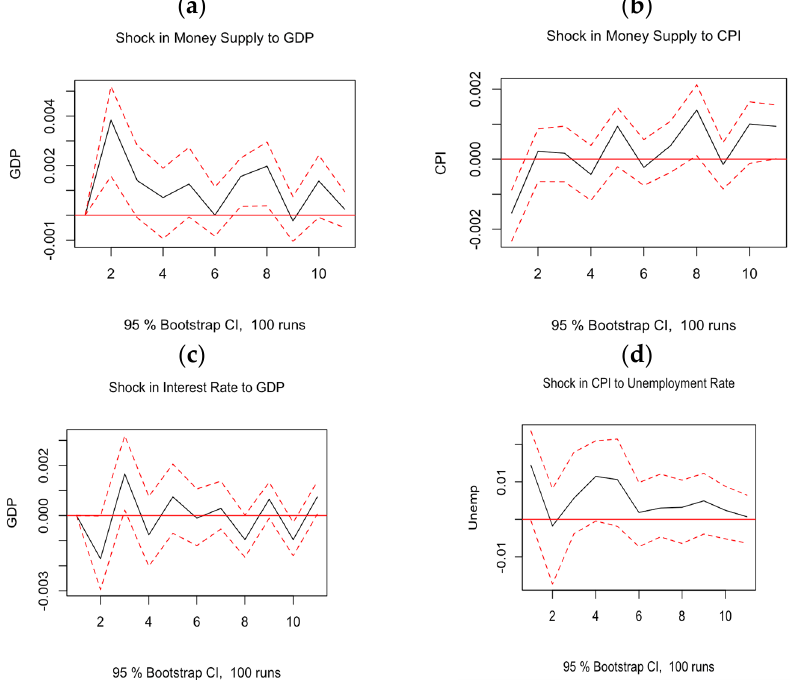
Figure 5. ( a , b ) Impulse Response Function (IRF) for Money Supply (M2) shock to Growth Domestic Product and shock to Consumer Price Index (CPI), respectively, ( c ) Impulse Response Function (IRF) for Interest Rate (IR) shock to Growth Domestic Product, and ( d ) Impulse Response Function (IRF) for Consumer Price Index shock to Unemployment.